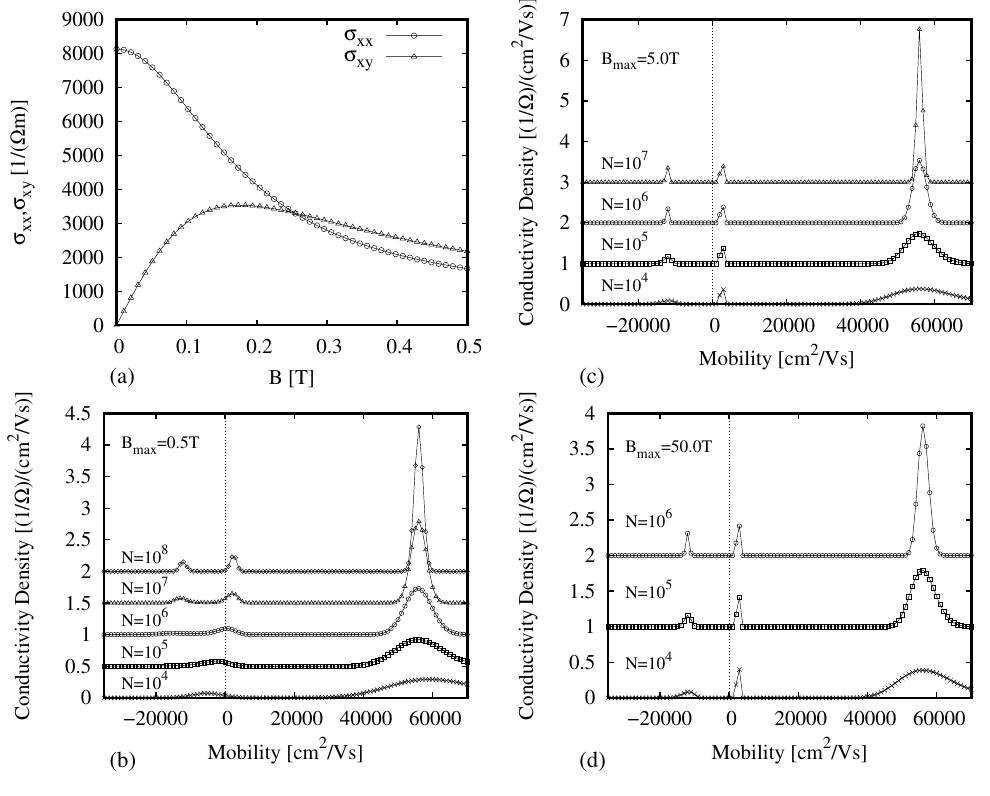
Figure A1. ( a ) Input data to test the numerical procedure of the mobility spectrum calculations. ( b – d ) Mobility spectrum calculated for different parameters N , dB and B max , as described in the